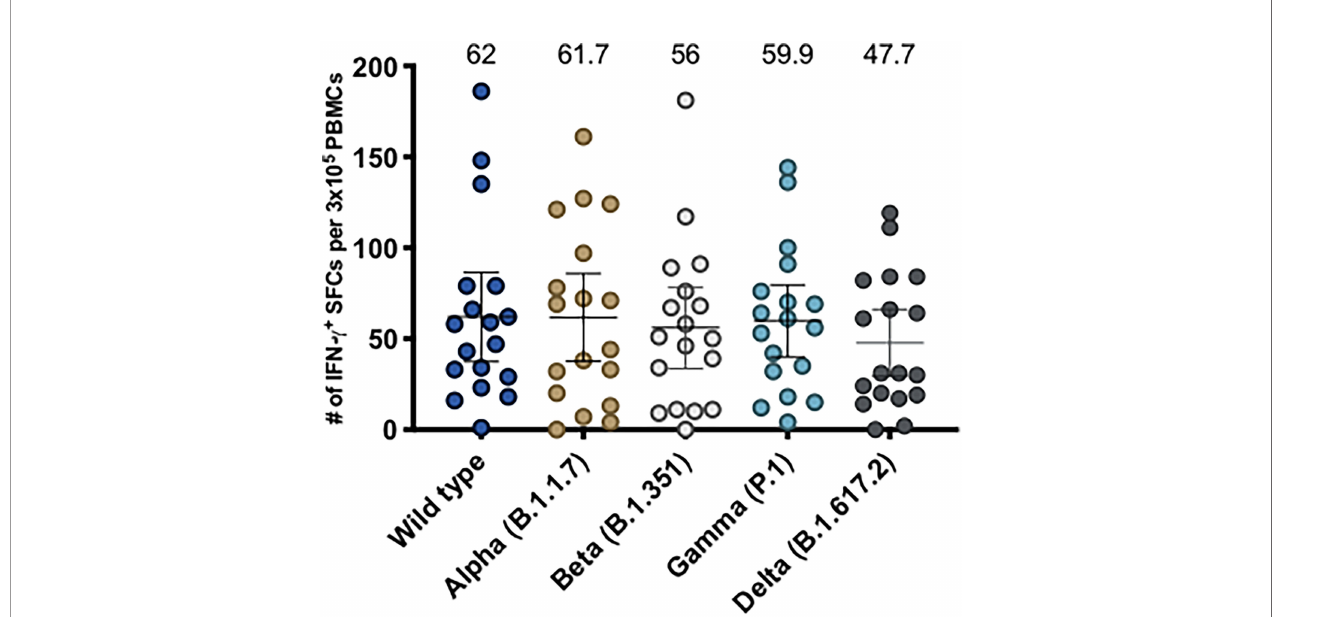
FIGURE 4 | Evaluation of cellular immune response through ELISPOT upon stimulation with Mega Pools of Spike peptides derived from SARS-CoV-2 WT and variants of concern in volunteers immunized with CoronaVac. Numbers of IFN- g -secreting cells, determined through ELISPOT as spot forming cells (SFCs) were determined. PBMCs were stimulated with MP-S WT, MP-S Alpha, MP-S Beta, MP-S Gamma and MP-S Delta for 48 h for samples obtained 2 weeks after the second dose of volunteers of the 0-14 schedule (n = 11) and 0-28 schedule (n = 7). A total of 18 volunteers were evaluated. Data shown represents mean ± 95% CI and the mean is indicated above each bar. Statistical differences were evaluated by a one-way ANOVA followed by Dunnett ’ s test for multiple comparisons against the MP-S